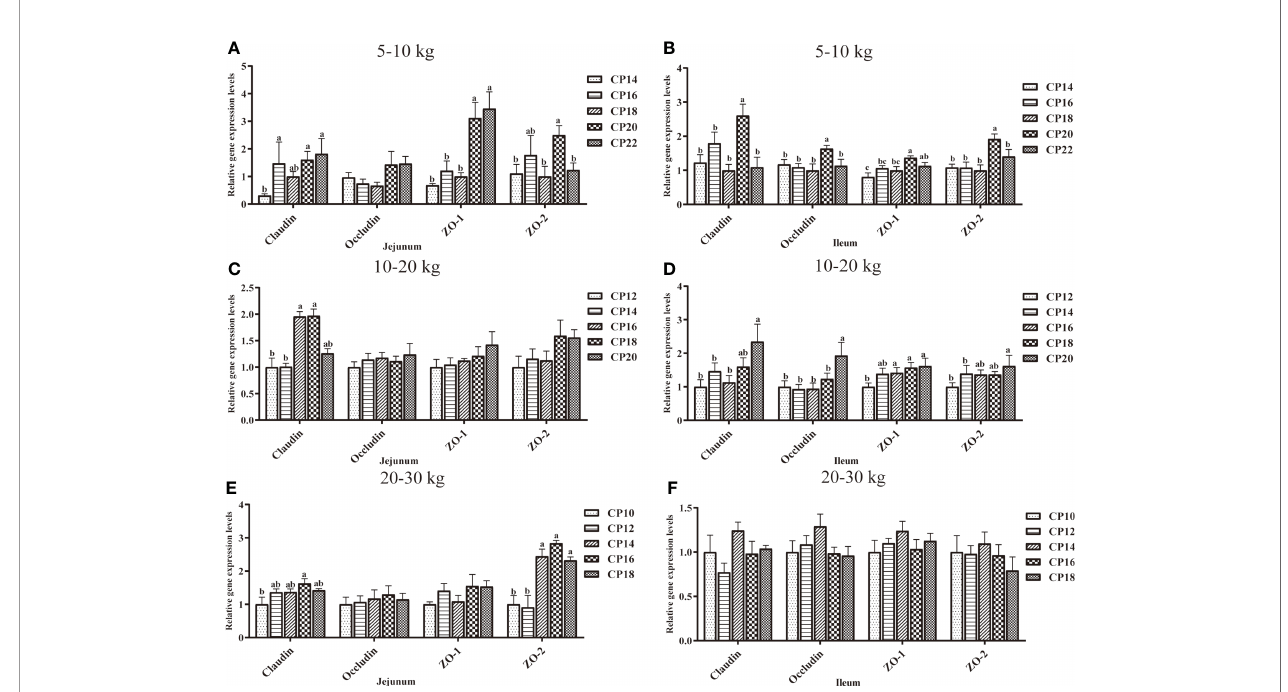
FIGURE 8 | Effects of dietary crude protein (CP) levels on the tight junction protein-related gene expression in the small intestinal mucosa of Huanjiang mini-pigs during 5 − 10 kg ( A , jejunum; B , ileum), 10 − 20 kg ( C , jejunum; D , ileum), and 20 − 30 kg ( E , jejunum; F , ileum) growth stages. Data are presented as means ± SE ( n = 6 − 8 per group). Different superscript letters indicate signi fi cant differences among the fi ve groups ( P < 0.05). ZO, zonula